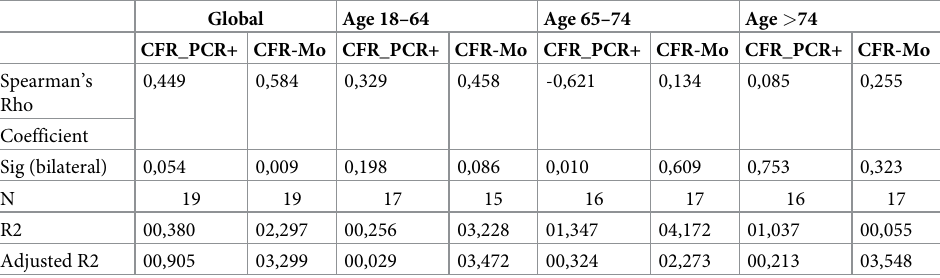
Table 4. Correlation between case fatality rate and prevalence of infection by age